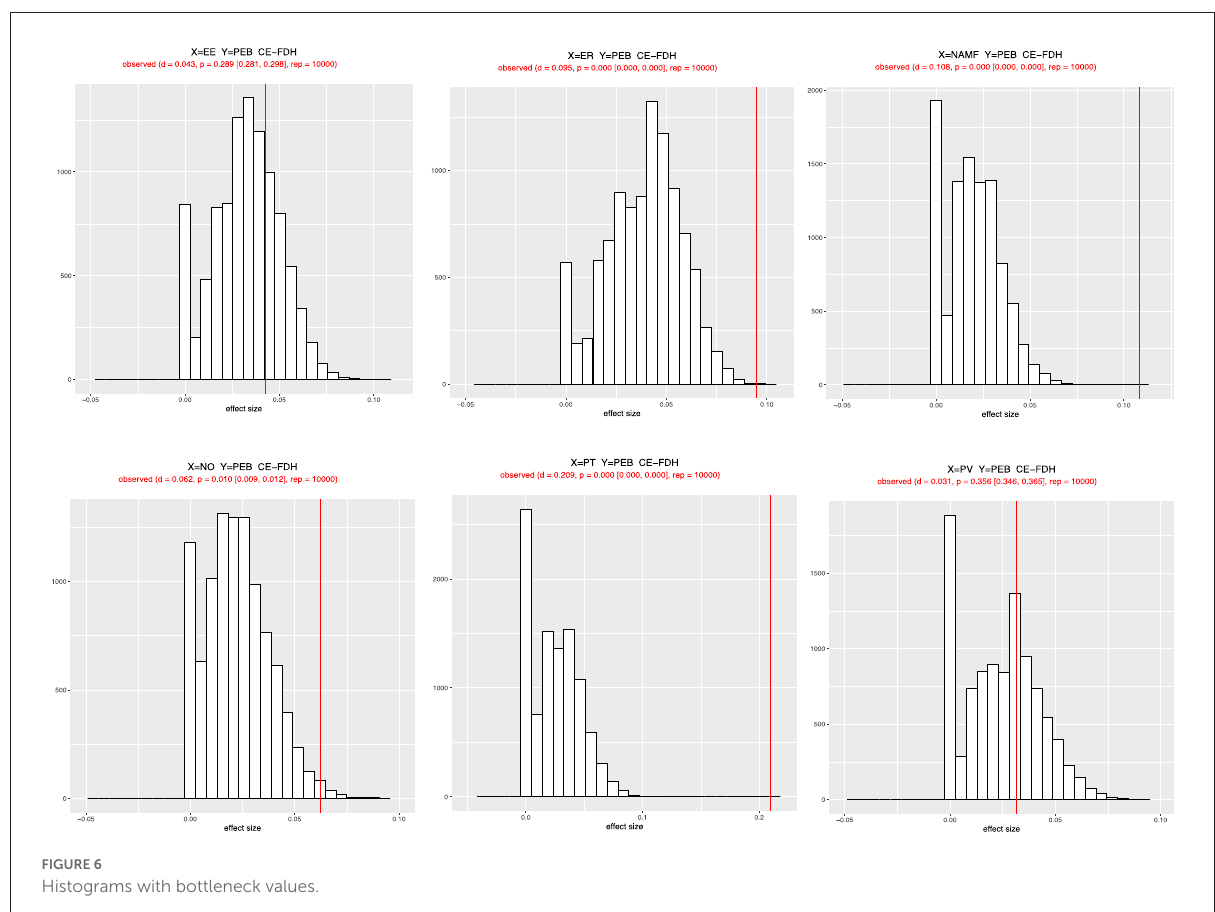
FIGURE6 Histograms with bottleneck